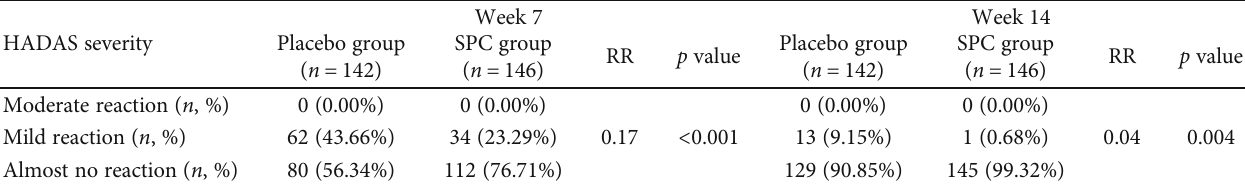
Table 4: Analysis of the overall proportions of HADAS severity in